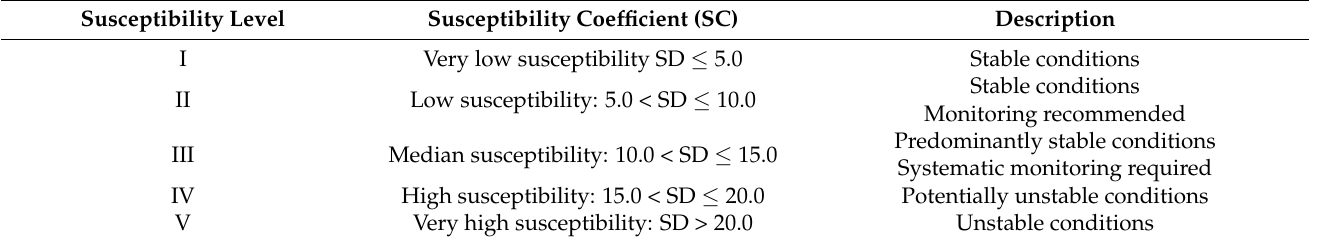
Table 6. Detachment susceptibility classification (rock mass). Based on [21,57,61,63,64].